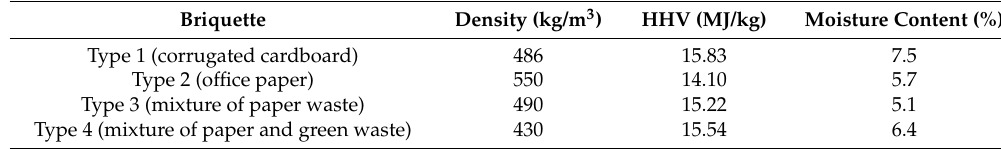
Table 1. Characteristics of briquettes used in this study [4].